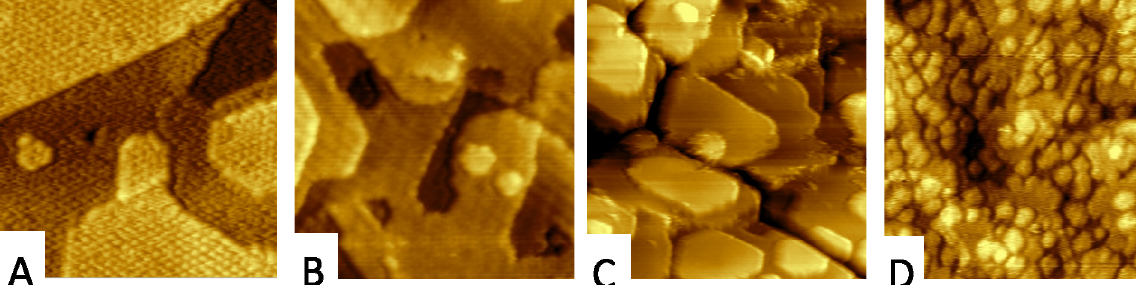
O layer on Cu(111). ( A ) the starting Ce O 2 3 2 3